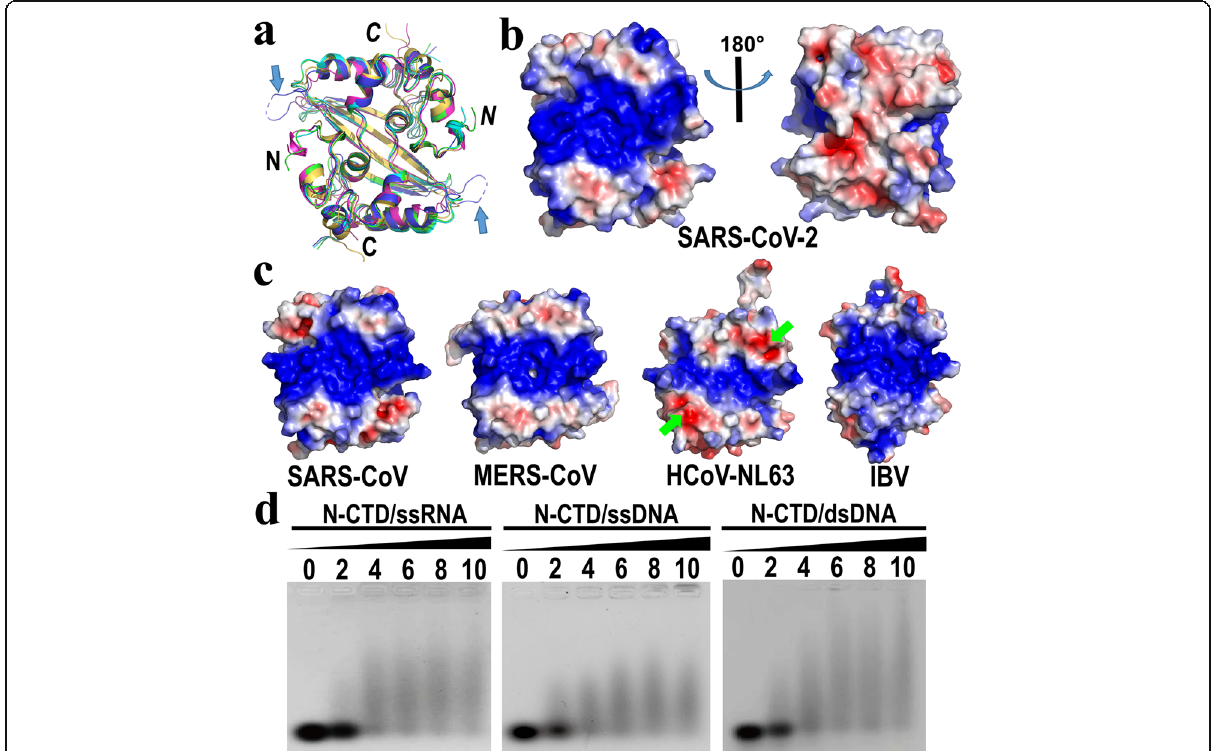
Fig. 3 Structural comparison of N-CTDs from various CoVs and oligonucleotide-binding assay of the SARS-CoV-2N-CTD. a Superposition of N- CTDs from SARS-CoV-2 (cyan), SARS-CoV (green, PDB code: 2CJR), MERS-CoV (blue, PDB code: 6G13), HCoV-NL63 (purple, PDB code: 5EPW) and IBV (yellow, PDB code: 2GE8). The N- and C- termini of subunits A and B (in italics) are labelled. The long insertion region of each β -hairpin in the MERS-CoV N-CTD is marked by a blue arrow. b The electrostatic surface of the SARS-CoV-2N-CTD dimer structure. The contouring level is -3 kBT/ e (red) to 3 kBT/e (blue). The helices side of the rectangular slab dimer shows a strong positively charged region for the potential RNA binding (left image). The opposite β -sheet side is almost a negatively charged and neutral region (right image). The orientation of the left image is same as in the ribbon representations in ( a ). c The electrostatic surfaces of the N-CTD dimers from SARS-CoV, MERS-CoV, HCoV-NL63 and IBV. The PDB codes used here are same as in ( a ). Residues Glu243/244 of each subunit in HCoV-NL63 are marked by green arrows. All orientations are same as in the ribbon view in ( a ). All figures were generated using the program PyMOL (https://pymol.org). d The EMSA experiment of the SARS-CoV-2N- CTD. The mobility shifts of ssRNA, ssDNA and dsDNA bound to the N-CTD are shown, respectively. The molar ratios of N-CTD/nucleotides in each lane are